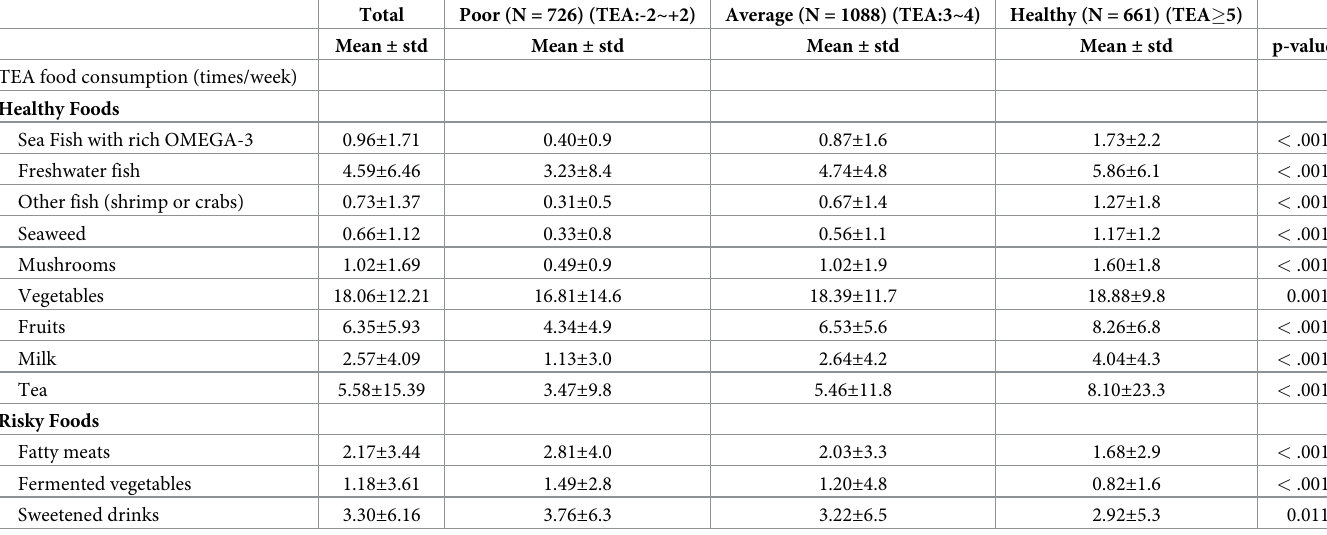
Table 2. Individual characteristics by dietary quality score, food items and intake frequency by foods score group.